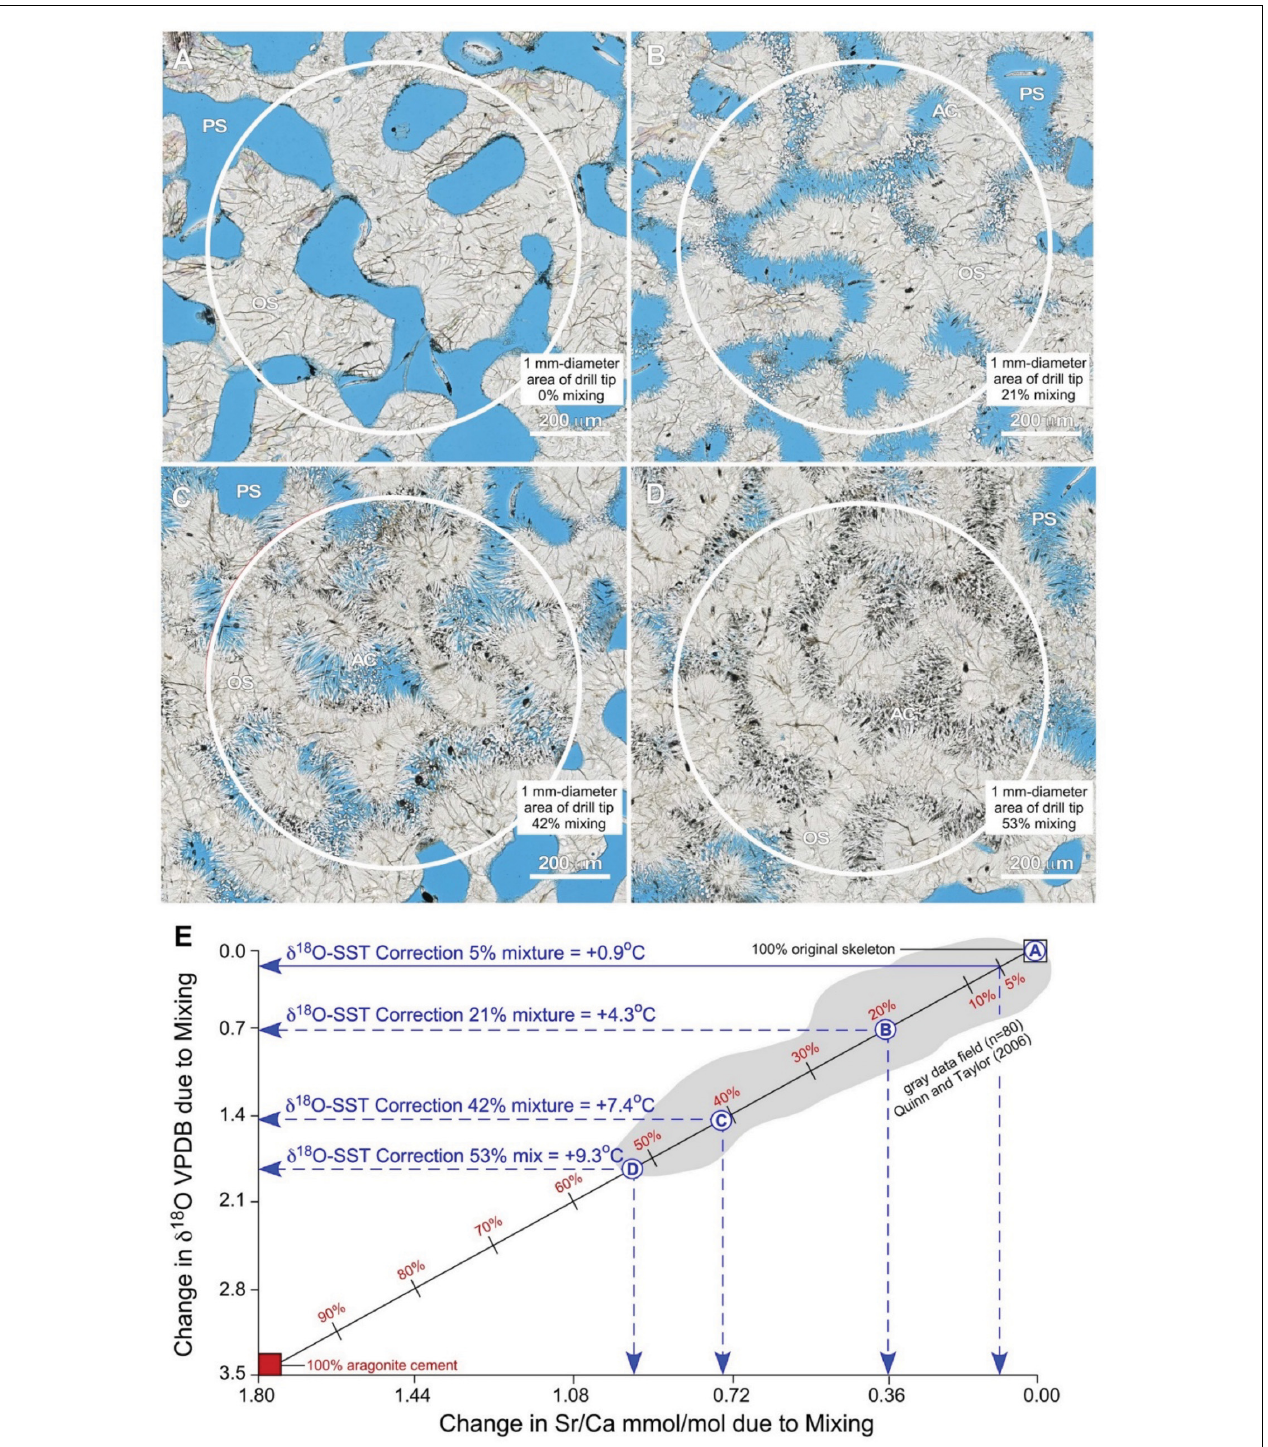
FIGURE 15 | Example integration of quantitative petrography with binary mixing modeling to estimate correction factors for the impact of seafloor diagenesis on δ 18 O-derived SST reconstructs from coral skeletons. (A–D) Nanozoomer BF images of high-density bands (HDBs) located 6 cm above the base of Core 3 ( Figures 2 , 6 ). Images of HDBs with 0% (A) , 21% (B) , 42% (C) , and 53% (D) cement occlusion are shown. A 1 mm-diameter drill tip (white circles) will yield a microdrilled sample powder composed of a mixture of original coral skeleton (SW) with diagenetic aragonite cements (AC) that grow into and occlude skeletal pore space (PS; black in ring aperture contrast, RAC). (E) A binary mixing line [calculated from Langmuir et al. (1978)] shows changing Sr/Ca mmol/mol vs. δ 18 O VPDB